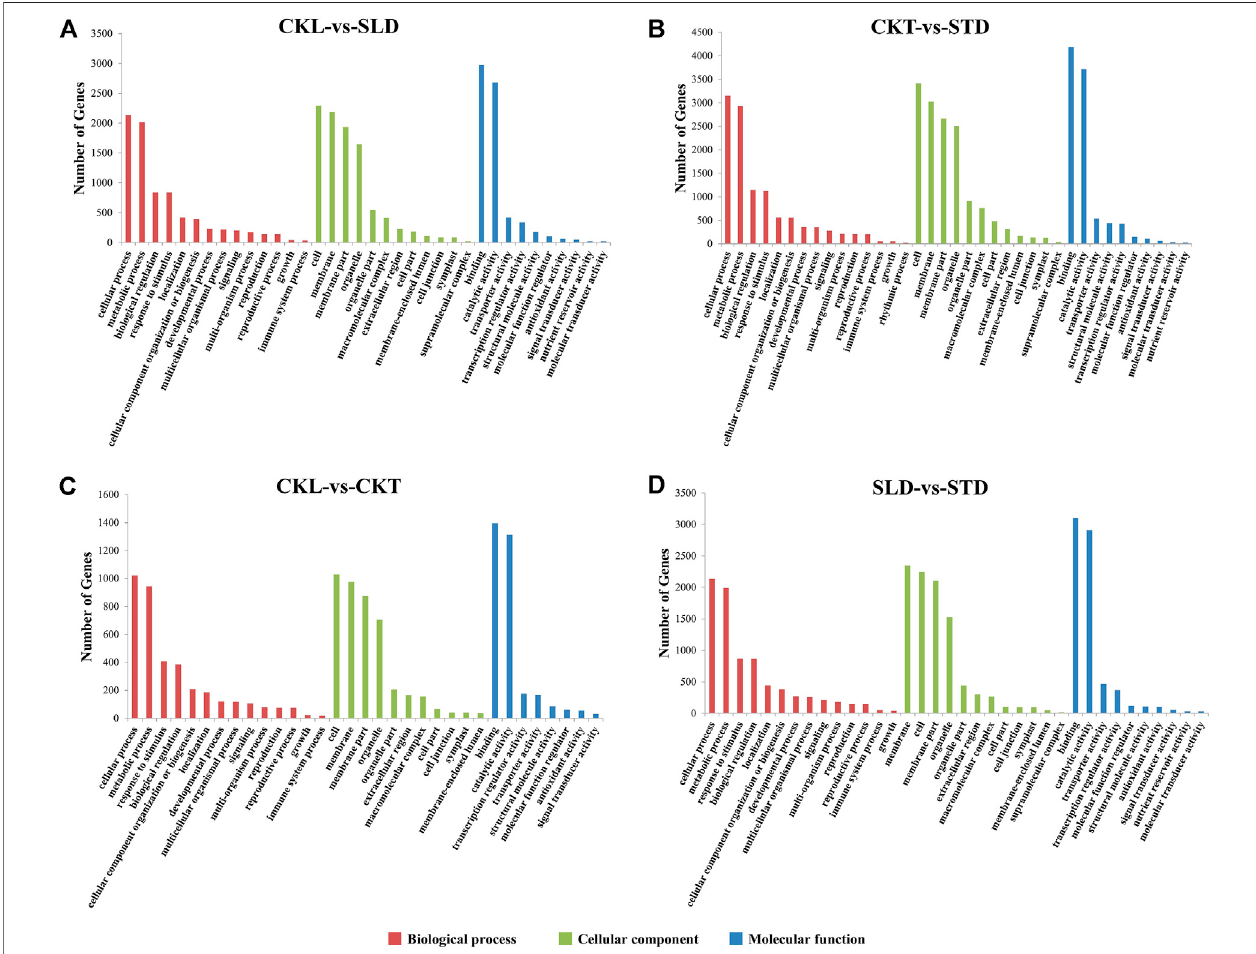
FIGURE3| GOenrichmentanalysisofDEGs in B. rapa underfreezingtreatments. TheGOterms inCKL vs .SLD (A) ,CKT vs .STD (B) ,CKL vs .CKT (C) ,and SLD vs . STD (D) . It is divided into 3 categories: Biological process, Cellular component and Molecular function which are represented by red, light green, and blue